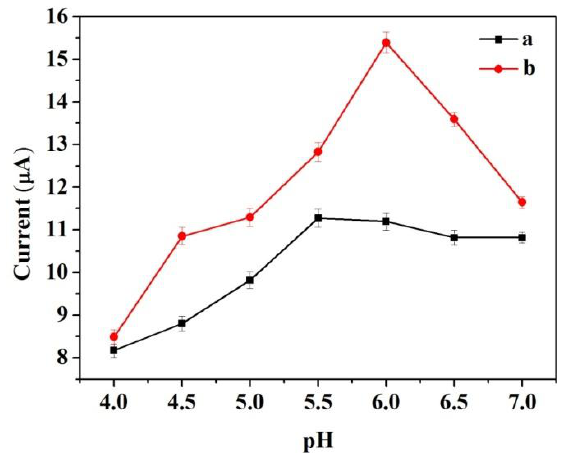
Figure 5. The dependence of the response of ( a ) CNFs/Lac/Nafion/GCE and ( b ) Cu/CNFs/Lac/Nafion/GCE to an input of 3.92 × 10 −4 M catechol on the pH of the buffer. Conditions: operating potential, 0.5 V versus Ag/AgCl reference. The error bars indicate the standard error for triplicate measurements with the same electrode.